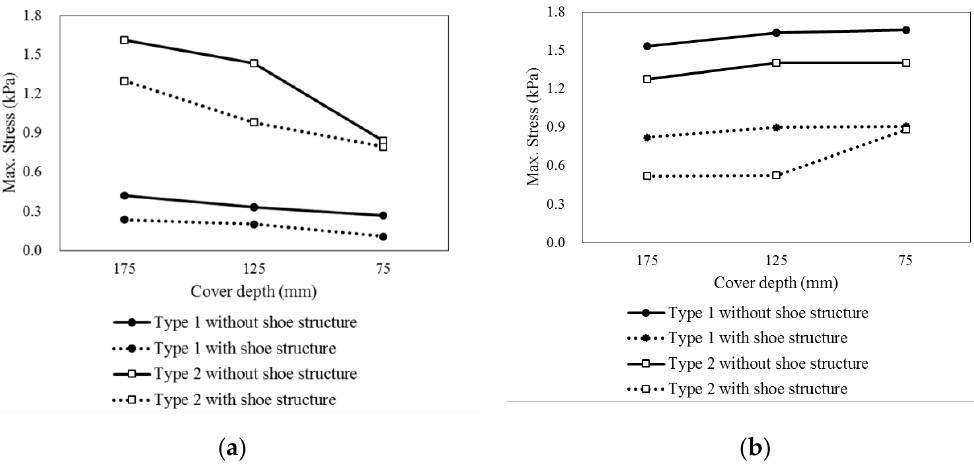
Figure 10. Maximum stress acting on piles during two stages according to cover depth: ( a ) during Stage 1. ( b ) During Stage 2.